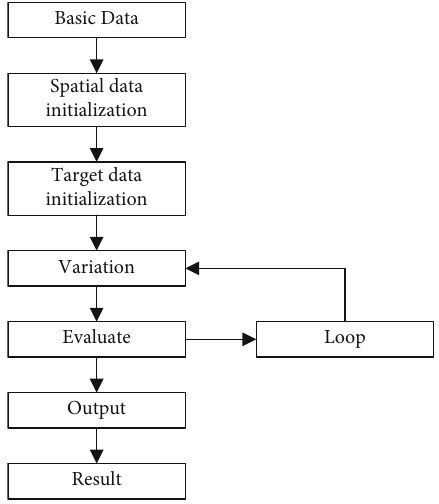
Figure 1: Schematic representation of the general patterns of the genetic algorithm. Basic Data: Basic data provided by the trading platform or the index platform software; Spatial data initialization: Basic data matrix for the Basic Data trip; Target data initialization: Based on the linear planning target data of the Basic Data itinerary, as the data to be varied; Variation: Data variation algorithms, such as the target weight variant algorithm designed in this study; Evaluate: Data evaluation algorithms, such as the weighted evaluation results given by the decision coe ffi cient R 2 used in this study and t in the bivariate di ff erence analysis; Loop: Algorithmic cycle branch, re-variant trigger results when poor user data evaluation results; Output & Result: Data analysis